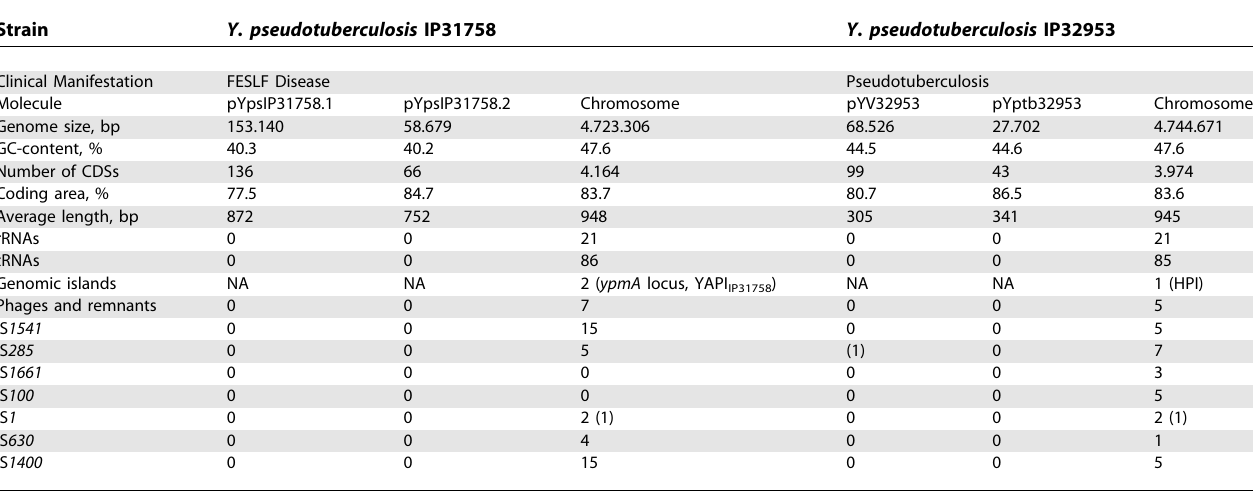
Table 1. Genomic Features of Y. pseudotuberculosis IP31758 and Comparison with Y. pseudotuberculosis IP32953